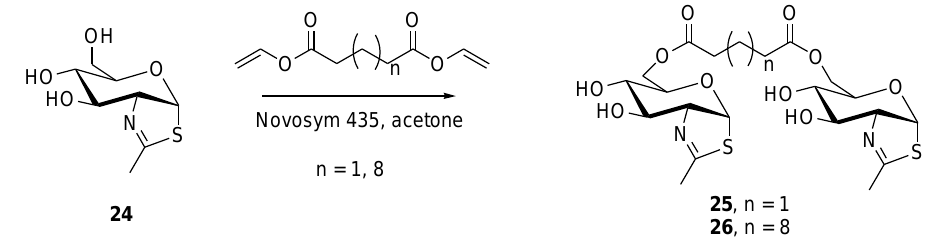
Figure 7. Enzymatic synthesis of NAG-thiazoline dimers 25 and 26 .